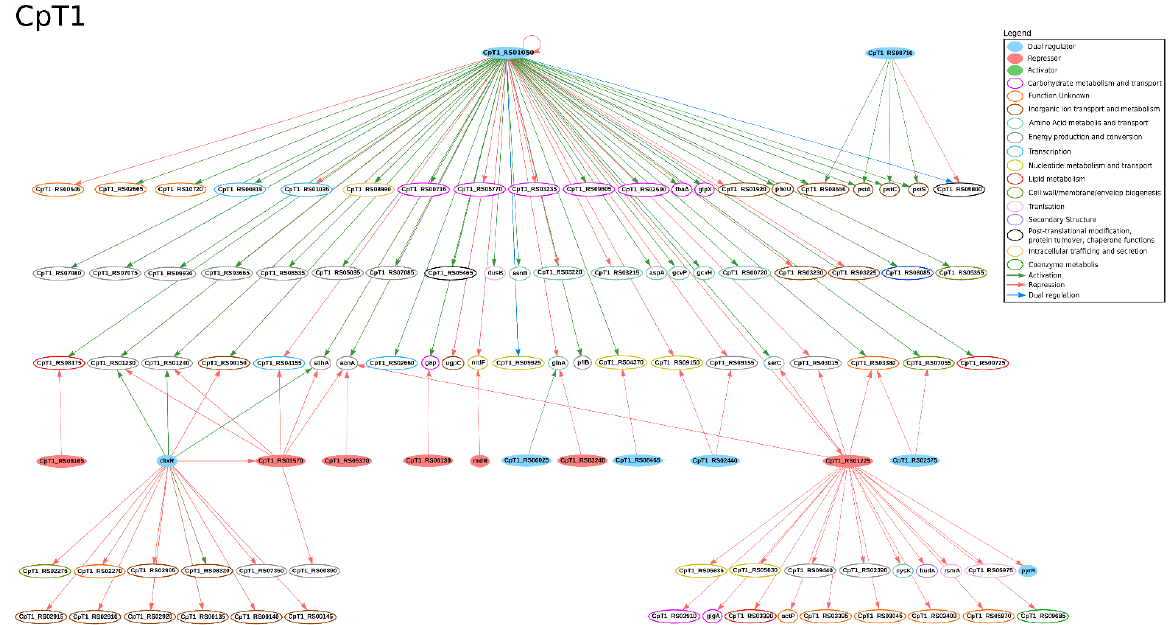
Figure 2. Regulatory interactions taken from CoryneRegNet 7 [22] for C . pseudotuberculosis T1 under iron limitation in [43]. In the network, nodes represent the genes and arrows represent the regulatory interactions. The functional classification was performed using the database Eggnog [90].